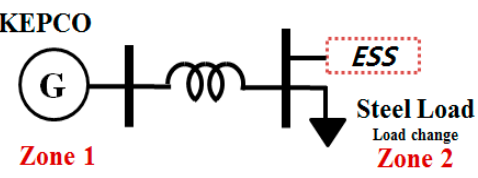
Figure 25. Power system model with ESS.